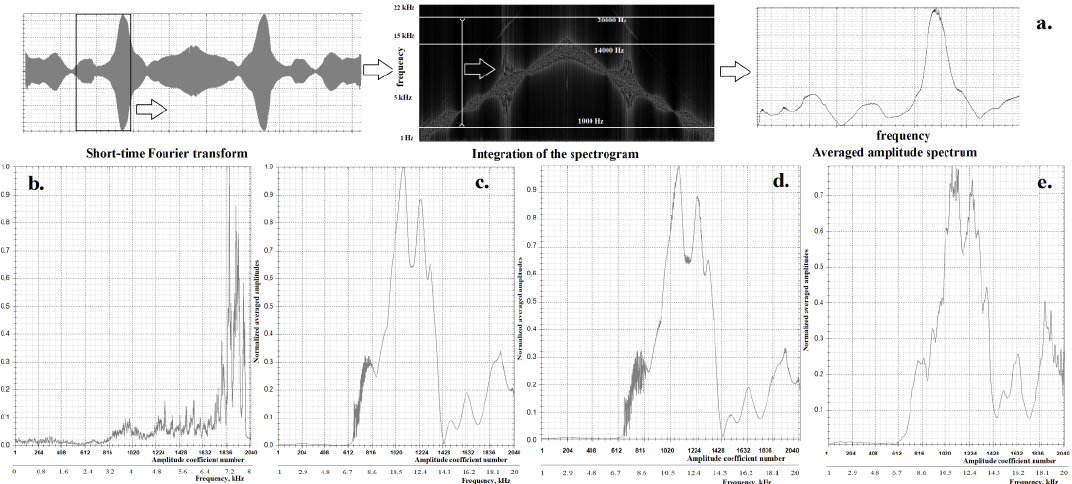
Figure 11. Average spectrum: ( a ) calculation process; ( b ) extracted from a voice image (from the TIMIT database) based on a rectangular window; ( c ) extracted from the acoustic image of the ear at the base of the Hamming window; ( d ) extracted from the acoustic image of the ear based on a rectangular window; ( e ) extracted from an acoustic image of an ear based on a Hamming window and reconstructed by an autoencoder.